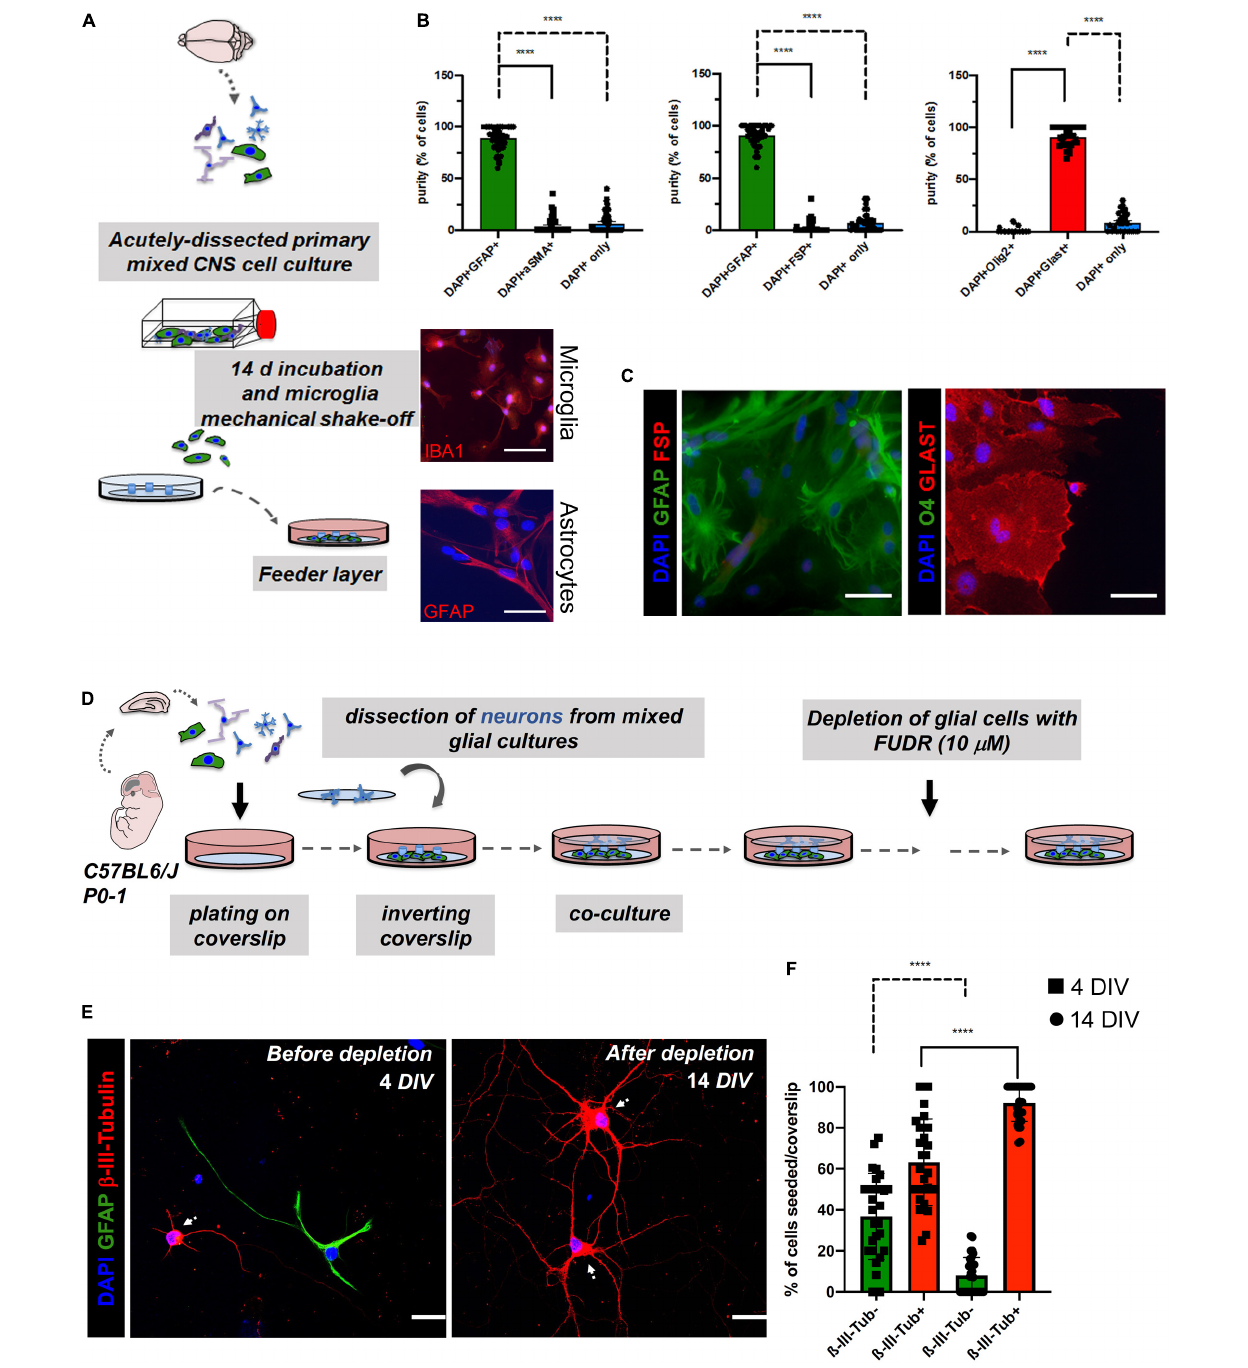
FIGURE 2 | Assessment of potential cell contaminations of the astrocyte feeder layer ( > 14 DIV ; lower coverslip) and effect of 5-Fluoro-2 (cid:48) -Deoxyuridine (FUDR) treatment on co-cultures at days 4 of neuron-astrocyte co-cultures (4 DIV ; upper coverslip) to ensure cell purity of the experimental setting. (A) Schematic overview of the generation of the astrocyte feeder layer. Microglia were removed from the astrocyte culture by vigorous shaking. Microglia could then be harvested by centrifugation of the culture supernatant and replated (upper image: representative IBA1 staining of isolated microglia in red; scale bar = 50 µ m; DAPI = nuclei in blue). Highly pure astrocytes are still attached to the surface of the culture flask after depletion of the microglia [lower image: representative glial fibrillary acidic protein (GFAP) staining of the purified astrocytes in red; scale bar = 50 µ m; DAPI = nuclei in blue]. (B) Quantification of double immunofluorescence analyses revealed a purity of the astrocyte layer of ≥ 90%. Here, astrocyte markers (GFAP or GLAST) were co-stained with markers of potentially contaminating cell populations such as fibroblasts (FSP; α SMA) or oligodendrocytes (O4). Data analysis was performed using GraphPad Prism 8 (GraphPad Software Inc., La Jolla, CA, United